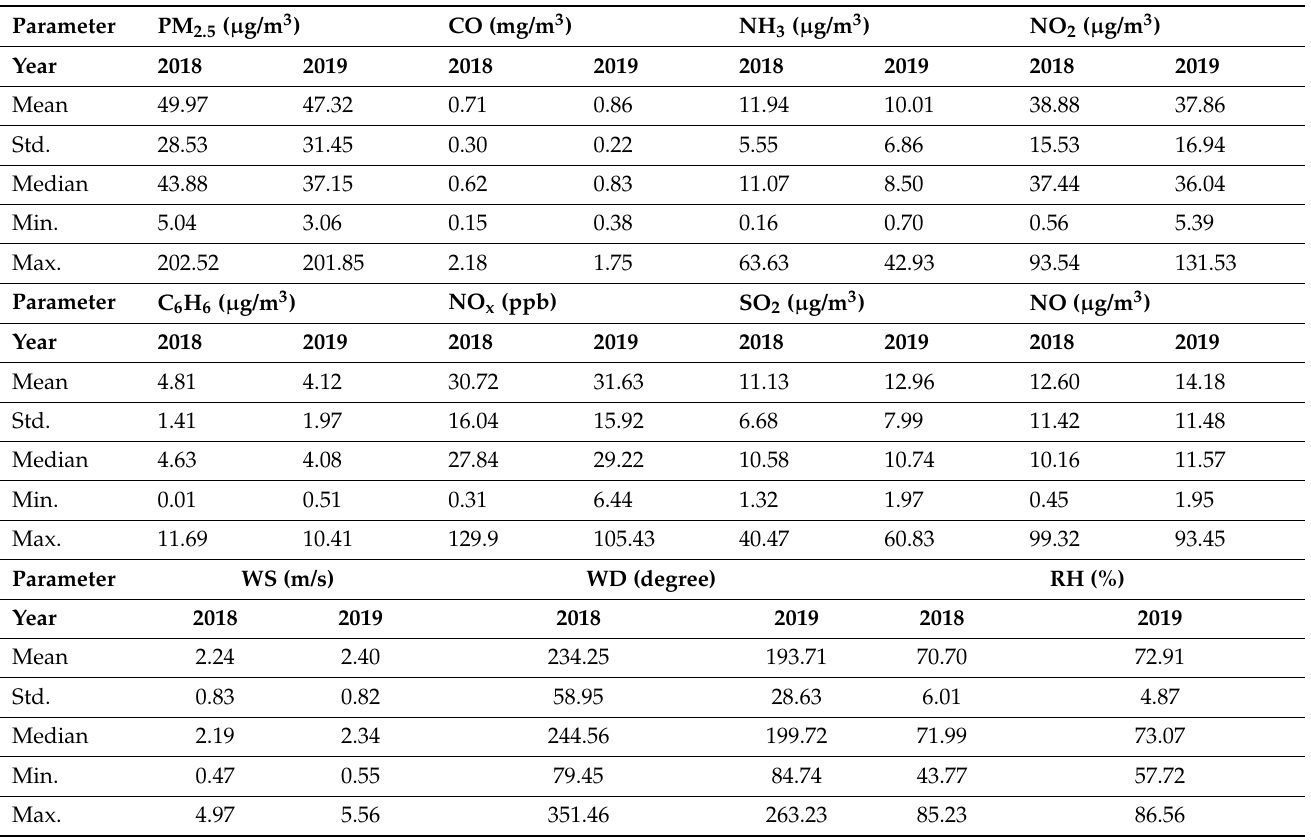
Table 7. Statistical description of PM 2.5 concentrations, air pollutants and meteorological parameters for the assessment year